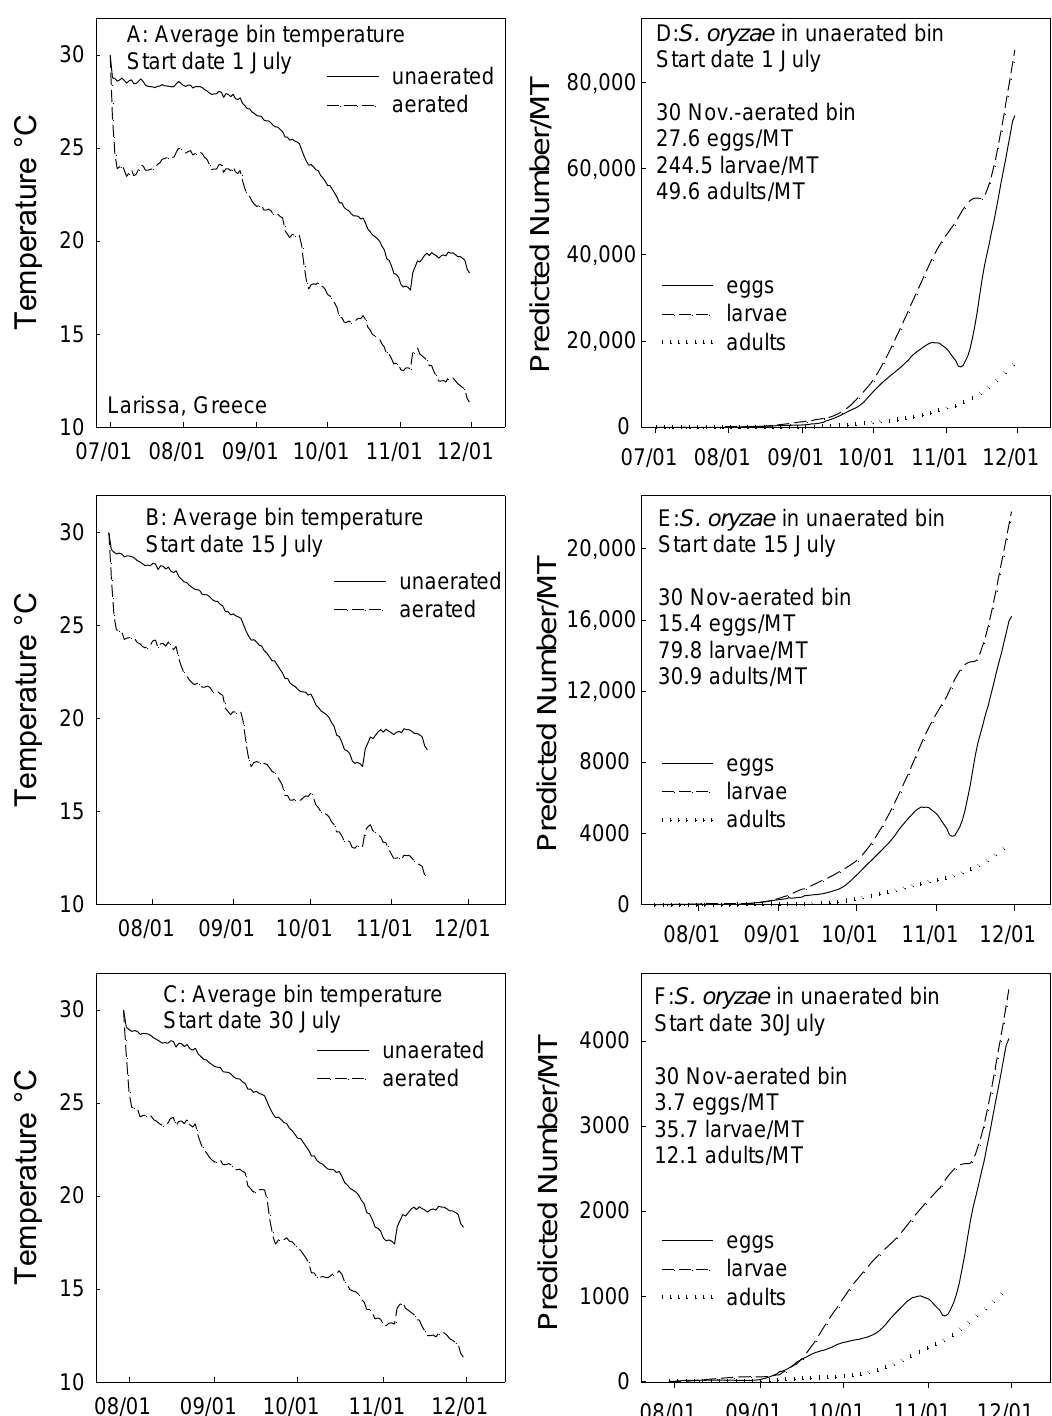
Figure 2. Predicted average bin temperatures in unaerated (solid line) and aerated wheat (dashed line) for wheat stored in Larissa, Greece, with start dates of 1, 15, and 30 July ( A – C ). Predicted populations of eggs, larvae, and adult S. oryzae (solid line, dashed line, dotted line, respectively) in unaerated wheat with those start dates are plotted in ( D – F ) Data for predicted populations of eggs, larvae, and adults in aerated wheat are given as text inside ( D – F ).